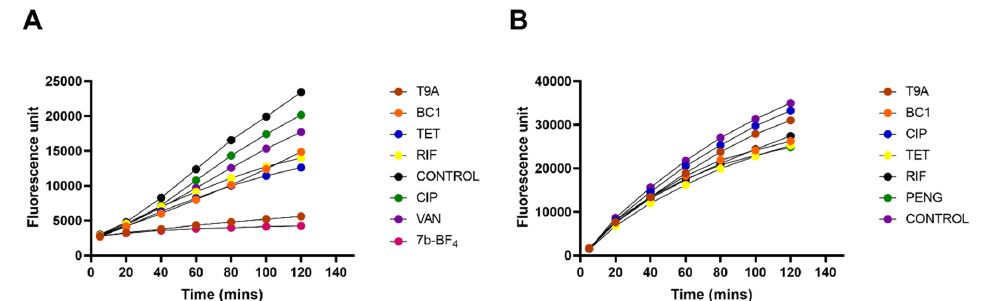
Figure 3. Assessment of the overall metabolic activity of B. subtilis and X. citri exposed to BC1 and T9A. Absolute fluorescence of resorufin measured over time in 20 min intervals in B. subtilis ( A ), and X. citri ( B ) cells. Fluorescence relative to the control is depicted in supplementary Figure S2. Control compound 7b-BF 4 is a compound that completely blocks B. subtilis respiration [20].